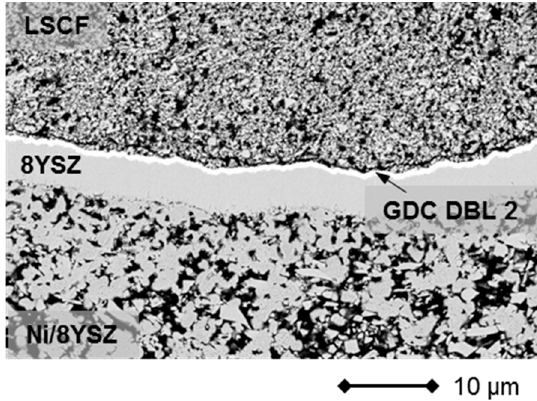
Figure 13. SEM image of a cross-section through an MSC highlighting the GFS applied 8YSZ electrolyte and the GDC diffusion barrier after operation. The cell was activated in situ for 100 h in a dual gas atmosphere at 850 °C and operated for 100 h at 750